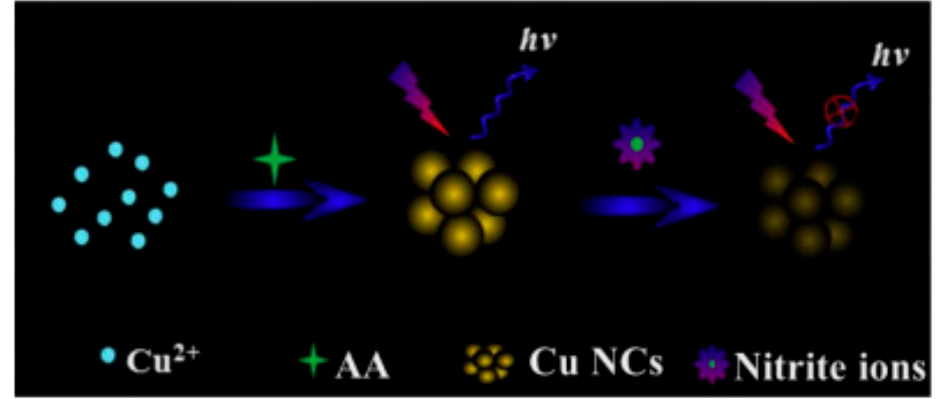
Figure 11. Schematic diagram of the mechanism of the detection of nitrite ions by the FL Cu NCs (Copyright Ref [139], Elsevier publications).